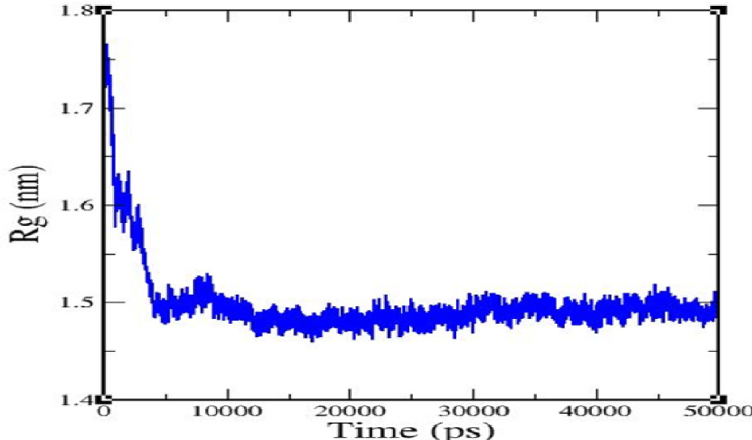
Figure 4. Radius of gyration of rutaecarpine against caspase 8.